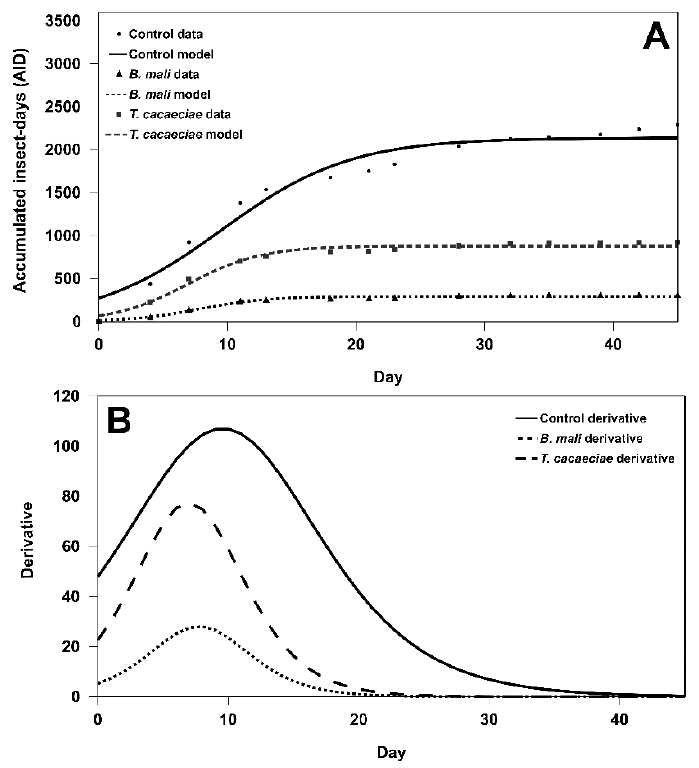
Figure 3. ( A ) Adjustments to simple logistic functions and ( B ) their derivative functions from the accumulated insect-days (AID) of P. operculella /container when an initial release of the predatory mite B. mali or the parasitoid T. cacaeciae was carried out, with respect to the control, under storage conditions (whiskers represent the confidence limits at p = 0.05). n = 4.